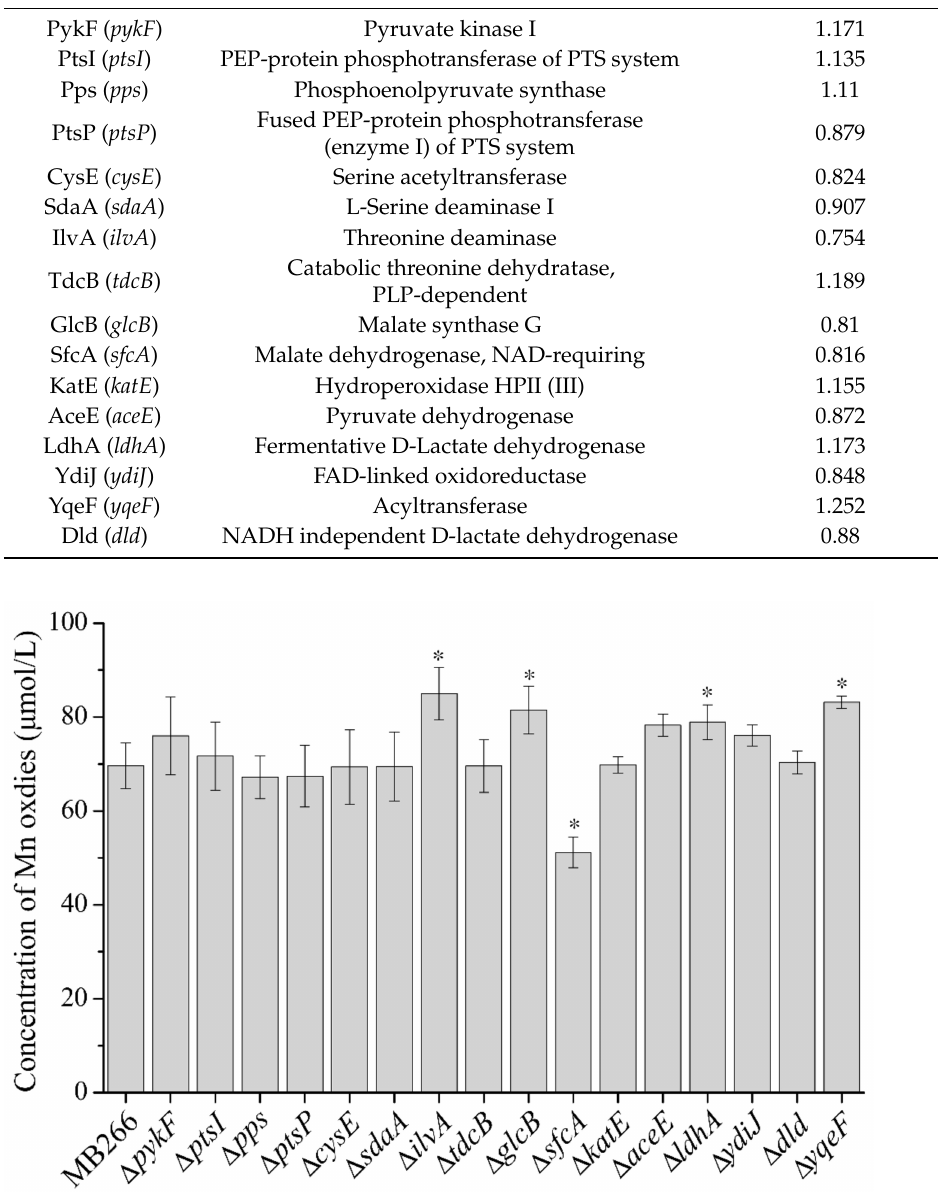
Figure 2. Measurement of MnODA of cell suspension in various gene-knockout mutant strains. The cells were cultured for 5 days under the supplement of 5 mmol/L MnCl 2 at the final concentration prior to the standard LBB assay. Means followed by * in a column were significantly different ( n = at least 3; p <